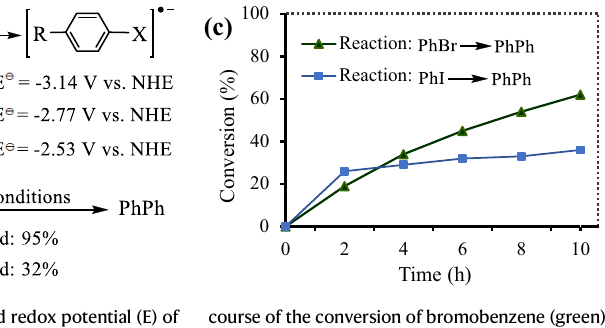
course of the conversion of bromobenzene (green) and iodobenzene (blue). PhBr: bromobenzene, PhI: iodobenzene, PhPh represents biphenyl. Source data are provided as a Source Data fi